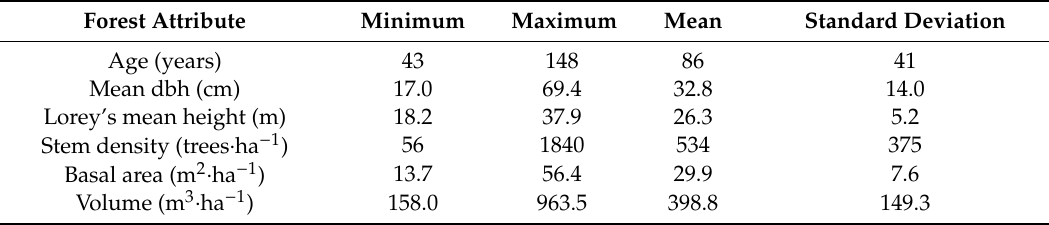
Table 1. Summary of the main forest attributes for the 99 measured sample plots. Forest Attribute